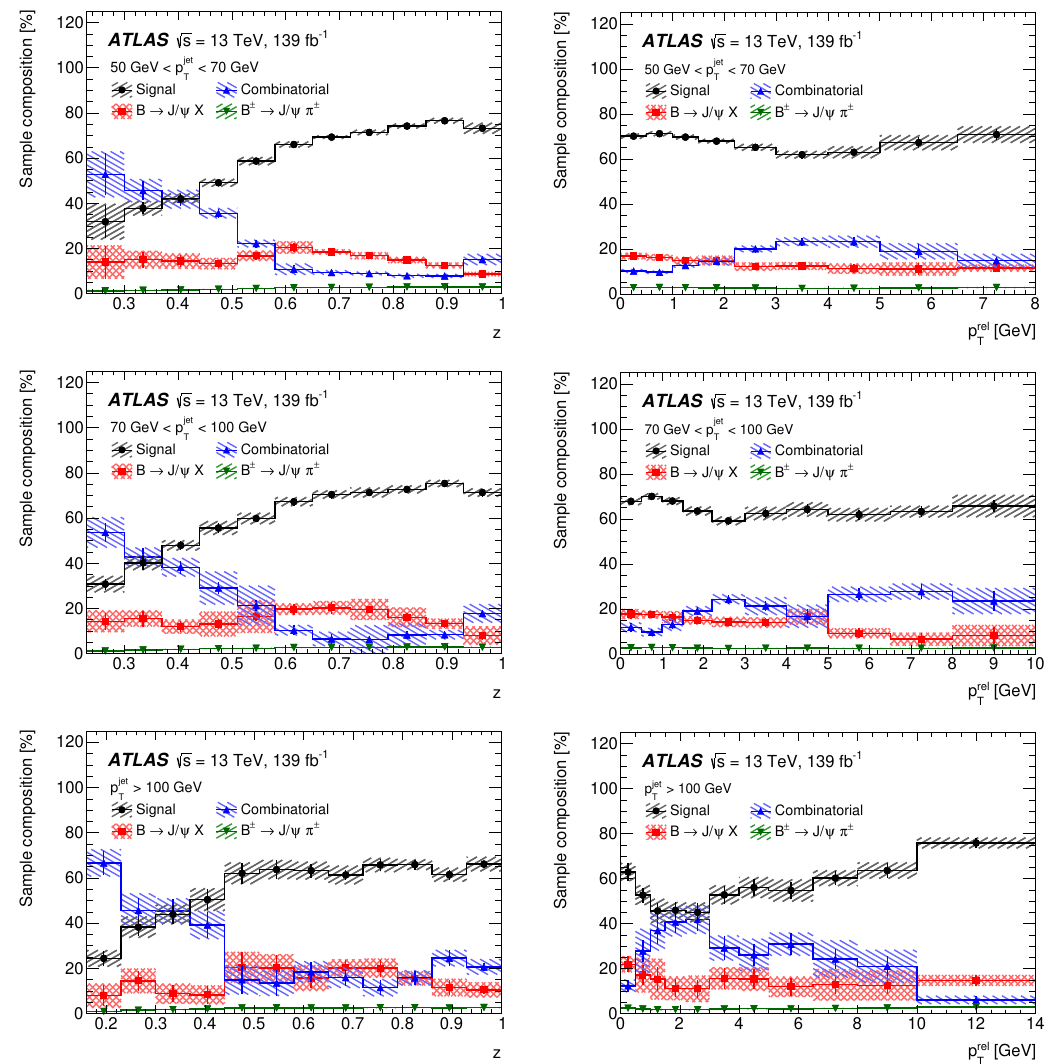
(right) T ) for each bin. The error T , x